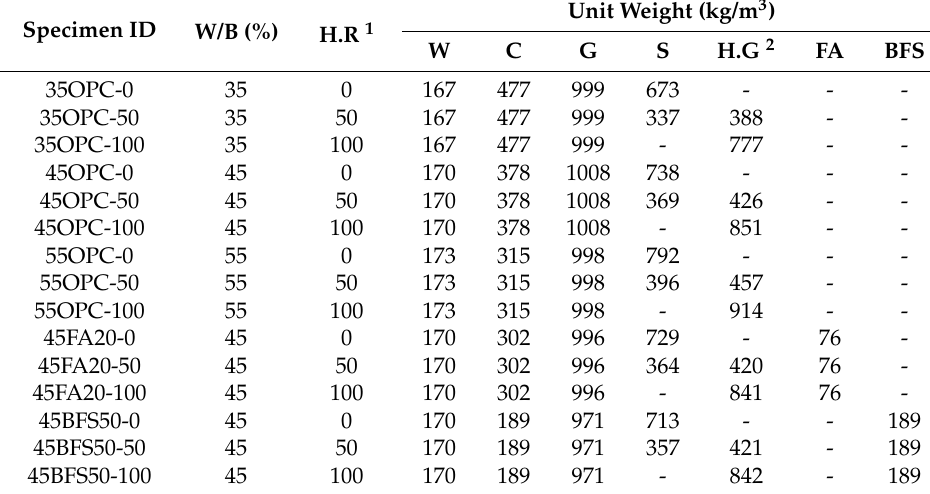
Table 4. Concrete mix proportion.